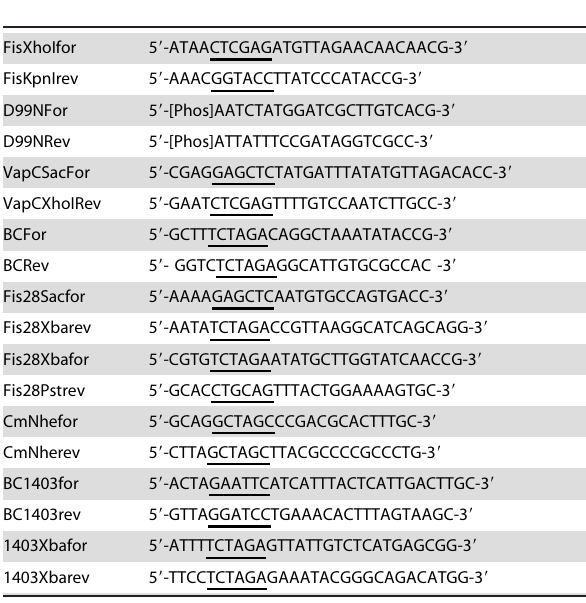
a Restriction enzyme sites used for cloning are underlined.